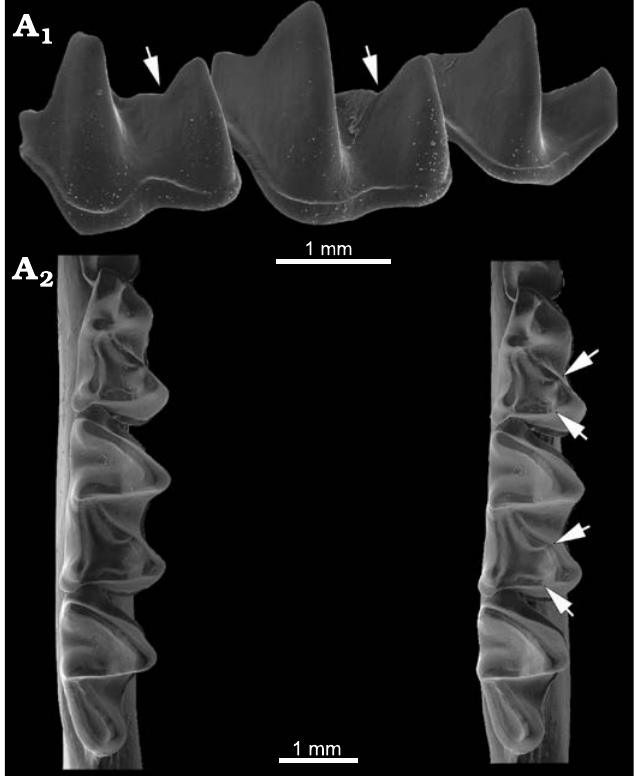
Fig. 5. Phyllostomid bat Macrotus waterhousii Gray, 1843 (OMNH 10653) from Mexico, Recent. Lower molars showing carnassiform notches in the cristid obliqua (arrows) and postcristid and accompanying accessory troughs in the talonid basins of m1–m2, in anterolabial view (A 1 ) and oc- clusal (A 2 , stereopair) views, notches indicated by